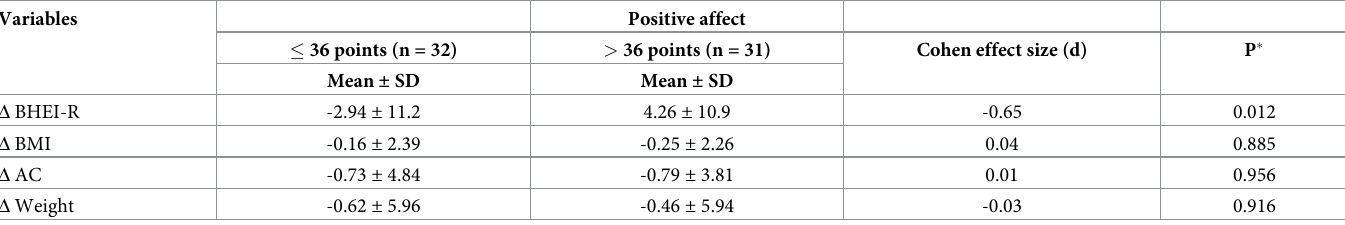
Δ : variation between the two times evaluated; BHEI-R: Brazilian Healthy Eating Index—Revised; BMI: body mass index; AC: abdominal circumference; SD: standard deviation � independent samples t-test. P-values are from independent t-test where the null hypothesis is delta =